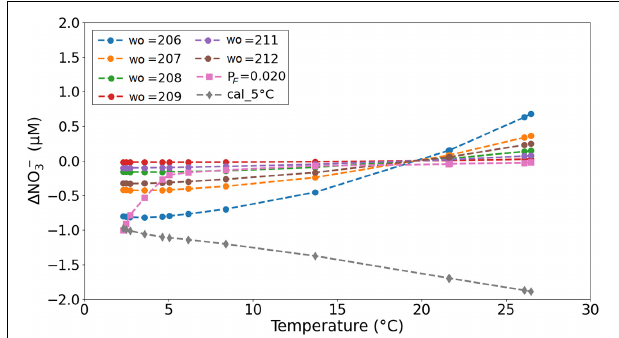
FIGURE 15 | Deviation of the NO 3 − estimation with a wo of 210 nm, P F of 0.026, and calibration file recorded at 20 ◦ C (OPUS-coefficients data presented in Figure 14A ) as a function of in situ sample temperature. The results for P F = 0.020 and calibration at 5 ◦ C were obtained at wo =